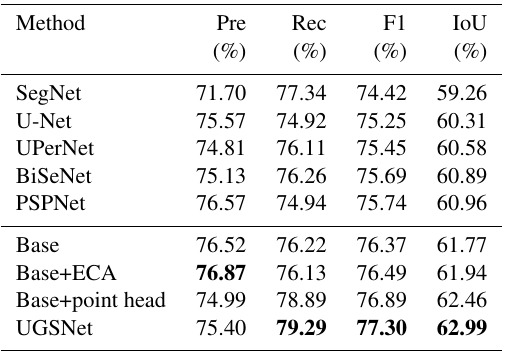
Table 5. Performance of the different semantic segmentation meth-